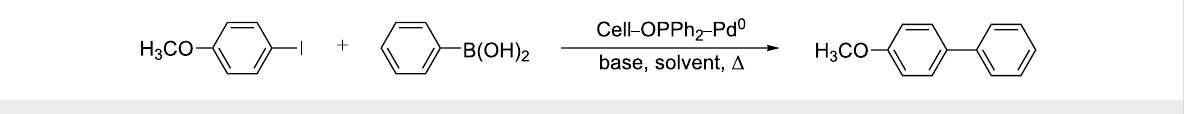
Scheme 2: Reaction of 4-iodoanisole with phenylboronic